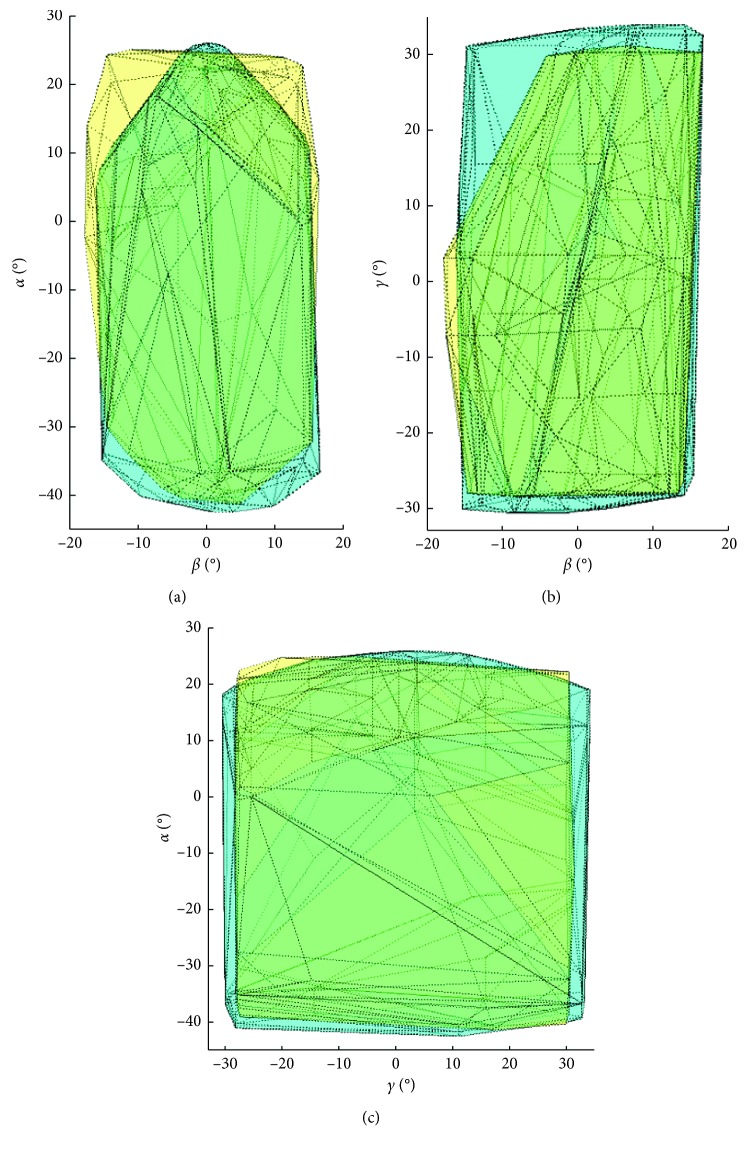
Projections of PMS and EWS at the coordinate {o0}. (a) Plane x0o0y0. (b) Plane y0o0z0. (c) Plane x0o0z0.